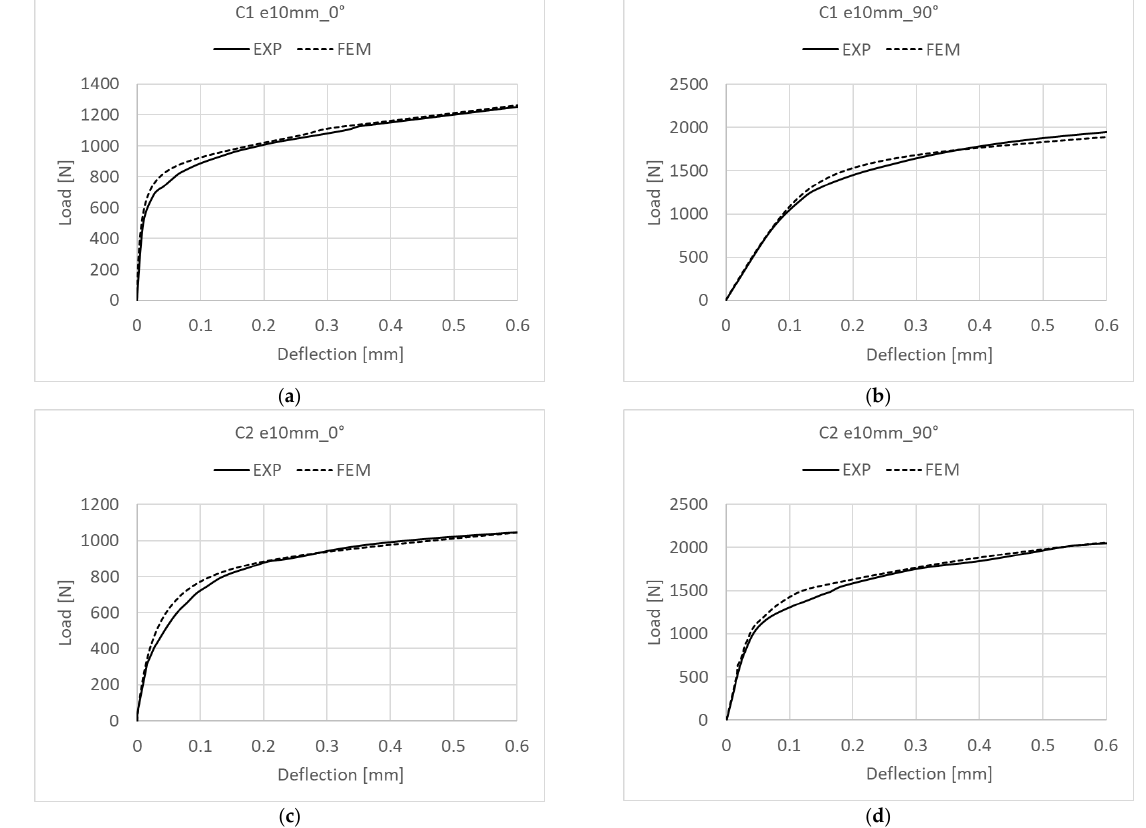
Figure 18. Experimental and numerical postbuckling equilibrium paths for: ( a ) C1 e10mm_0°, ( b ) C1